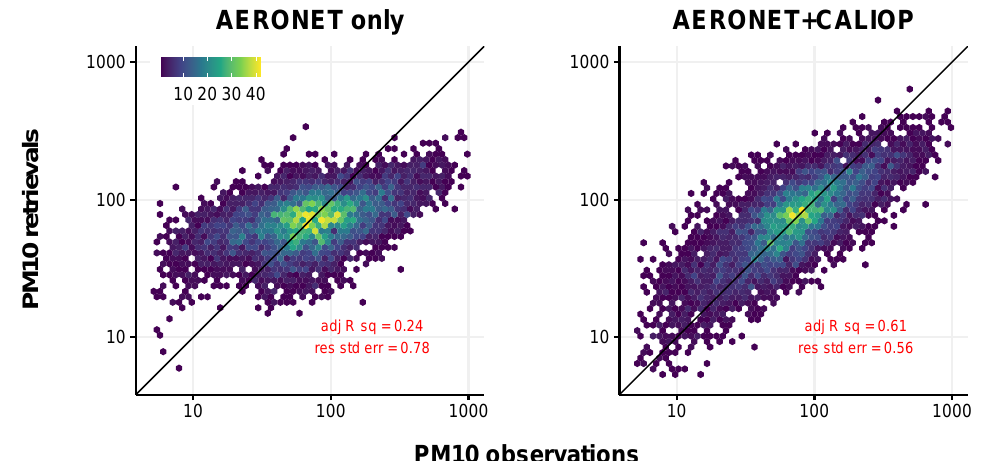
Figure 5. Scatter plot of measured and predicted daily PM10 in µ g/m 3 considering ( left ) AERONET AOD only and ( right ) AERONET AOD and CALIOP parameters. Number of points N = 6509, ajd R sq is the adjusted coefficient of determination, and res std err is the residual standard